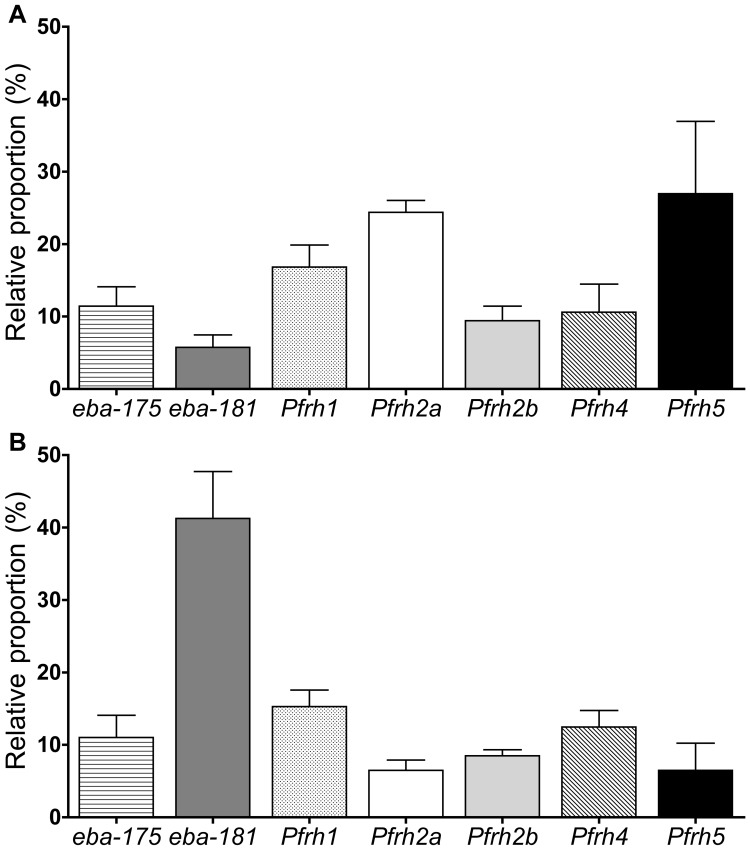

Pfrh2a, Pfrh5 and eba-181 are the most abundantly expressed ligand transcripts infield isolates utilizing the NrTrCr invasion profile.Each bar shows the relative proportion value for each transcript as a percentage of all seven transcripts including eba-175, eba-181, Pfrh1, Pfrh2a, Pfrh2b, Pfrh4 and Pfrh5. Values are given as means ± standard errors of the means. (A) Comparison of the transcriptional levels of the ligands between parasites utilizing NrTrCr and NsTrCr invasion profiles. (B) Comparison of the transcriptional levels of the ligands between parasites utilizing NrTrCr and NrTsCr invasion profiles.